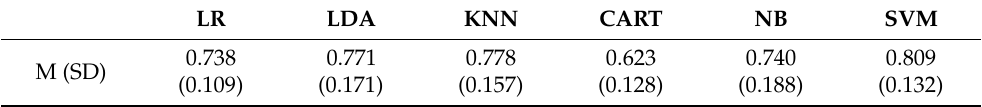
Table 9. Algorithm